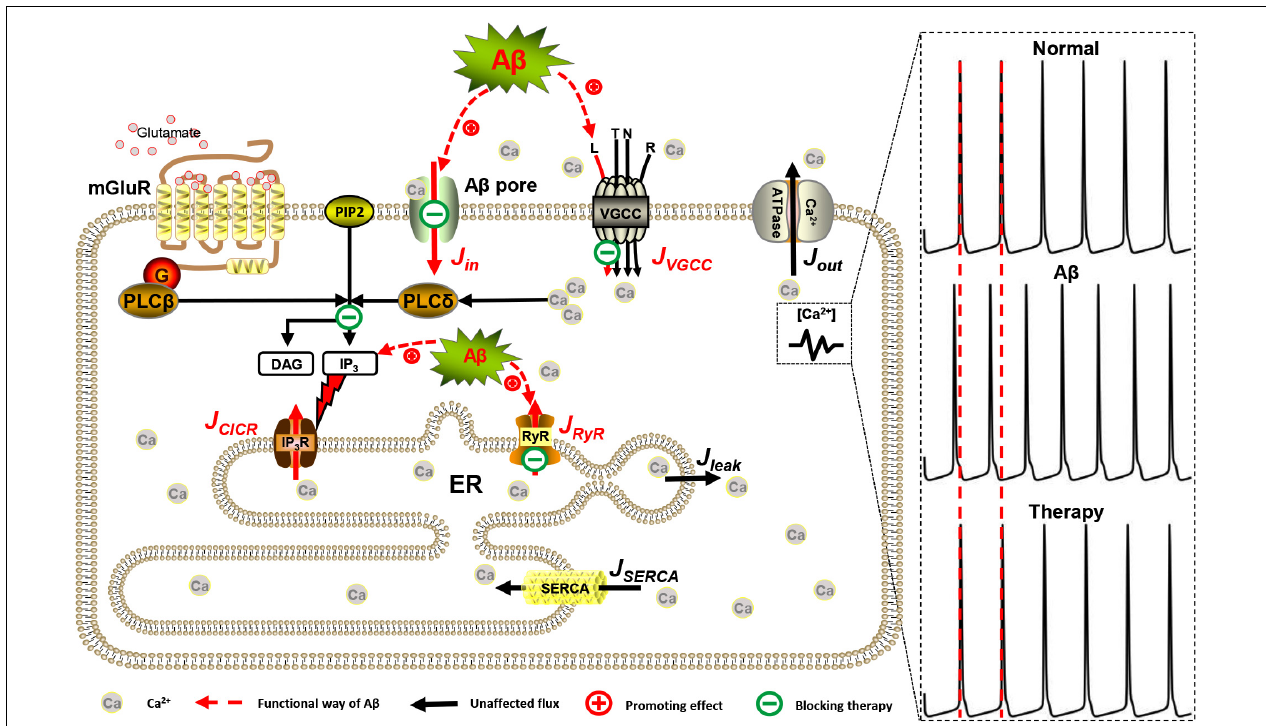
FIGURE 1 | Mechanisms involved in intracellular Ca 2 + dysregulation in AD. In this model, J VGCC and J in are Ca 2 + influxes from the extracellular space. The two separate mechanisms involved in the process of Ca 2 + release from the ER via IP 3 Rs and RyRs are J CICR and J RyR , respectively. J SERCA represents the SERCA pump of the ER refilling the ER by pumping Ca 2 + back from the cytosol. J leak is the leakage Ca 2 + flux from the ER into the cytosol. J out is Ca 2 + efflux by Ca 2 + -ATPase pump. Red lines represent the functional pathway of A β , and green lines represent the inhibitory effects of